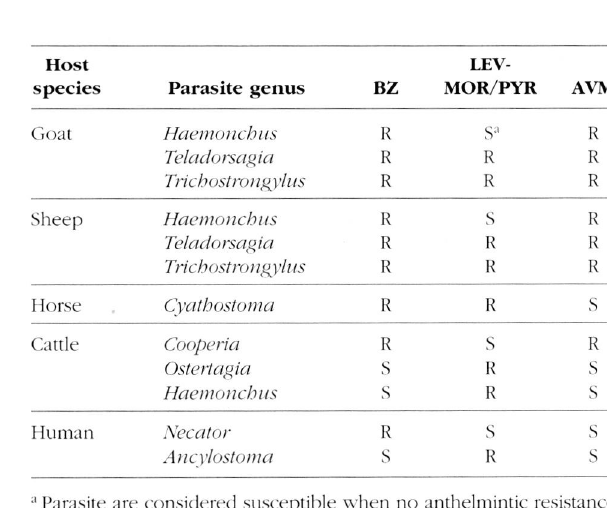
Table I. - Anthelmintic resistance recorded in farm animals and